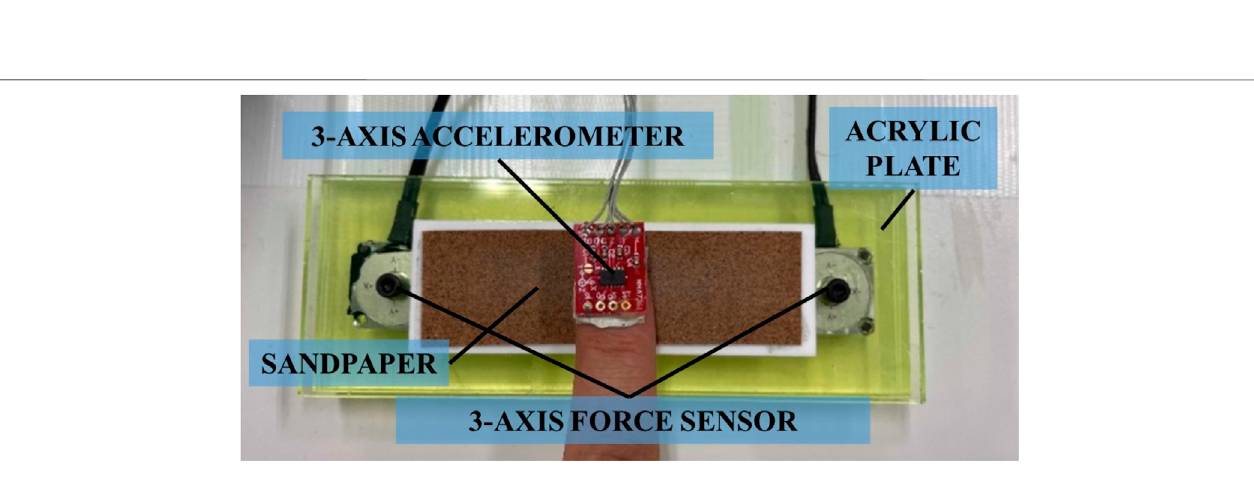
FIGURE 3 | System for direct measurement of acceleration and frictional